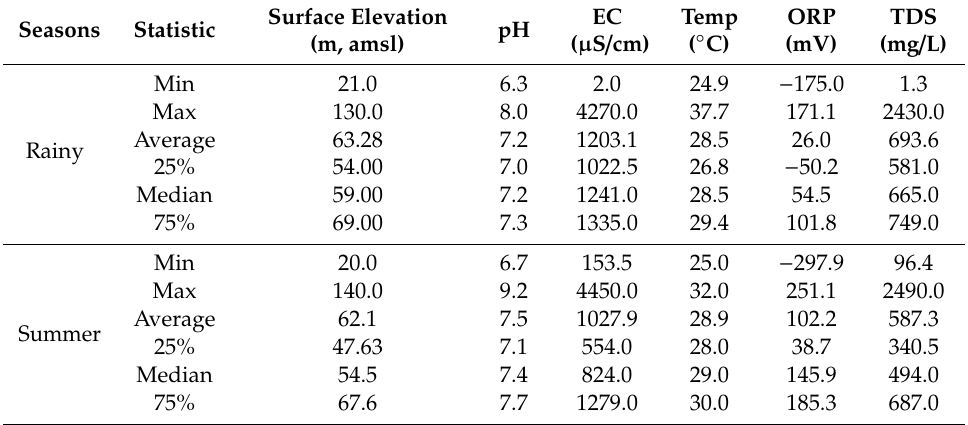
Table 1. Summary of statistic of measured field parameters in 60 groundwater